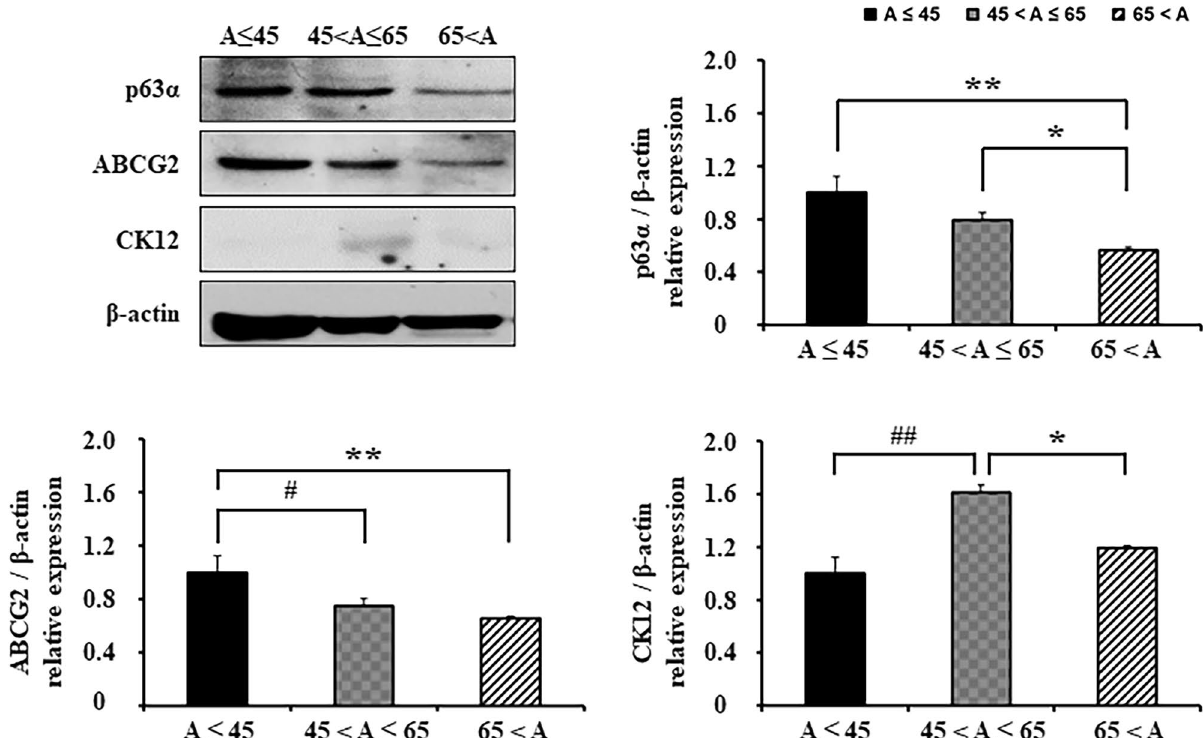
Figure 3. Protein expression of limbal epithelial outgrowth sheets from different donor’s ages. Representative western blot images of p63α, ABCG2 and CK12. The protein expressions of p63α, ABCG2, CK12 and β-actin were developed from the same gel in western blot. All signal intensities were normalized to the signal generated in the same sample by β-actin. Expression levels of p63a, ABCG2, CK12, and β-actin were obtained from the same gel in the western blot. *p < 0.05 (vs. 65 < A), **p < 0.01 (vs. 65 < A), # p < 0.05 (vs. 45 < A ≤ 65), ## p < 0.01 (vs. 45 < A ≤ 65), n = 6 from 3